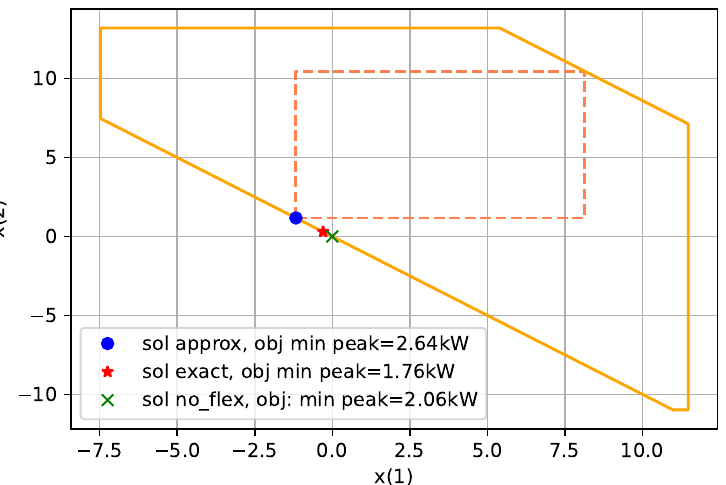
Figure 9. Example for peak power UPR value greater than 1 for the algorithm IA with Cuboid Homothets Stage 0: The polytope with solid lines represents the M-sum of two household flexibilities and the polytope with dashed lines the inner approximation to the M-sum. The solution obtained for peak power minimization is indicated with a circle for the inner approximation, with a star for the M-sum, and with a cross for no flexibility, i.e., x = ( 0,0 ) (cid:62) . The case with no flexibility leads to less peak power than the solution for the inner